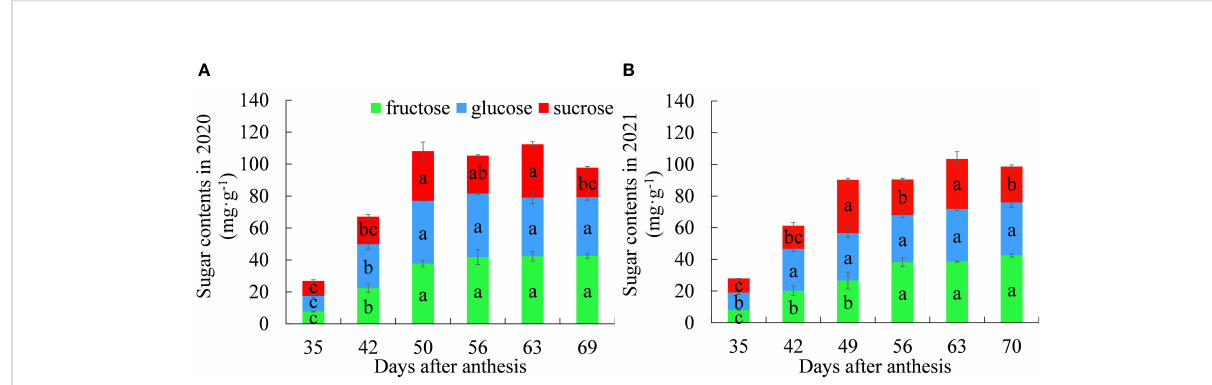
FIGURE 1 Dynamic changes in the contents of fructose, glucose and sucrose between (A) 2020 and (B) 2021. Different letters indicate signi fi cant differences during growth at P = 0.05. Error bars represent the standard error of the mean ( SEM